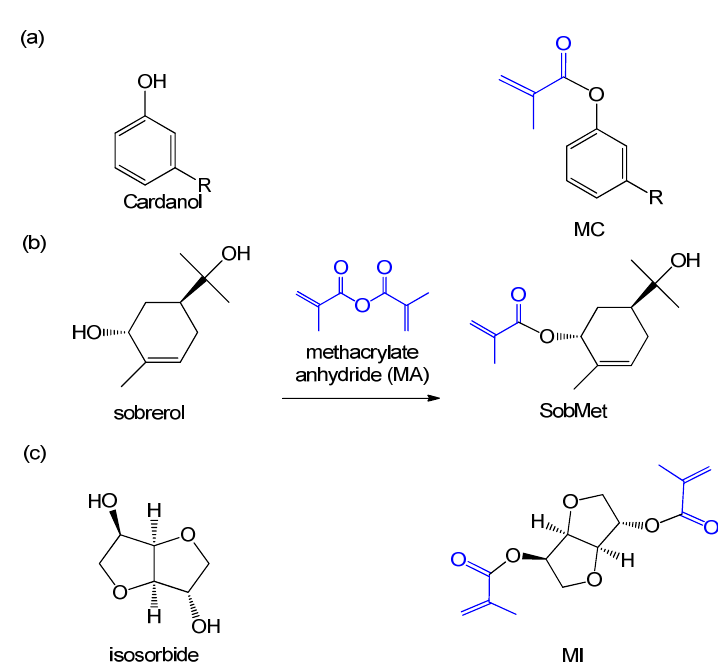
Figure 5. Synthesis of biobased reactive diluents (RDs) from ( a ) cardanol, ( b ) sobrerol, and ( c ) isosorbide renewable monomers via grafting with MA [50–52].